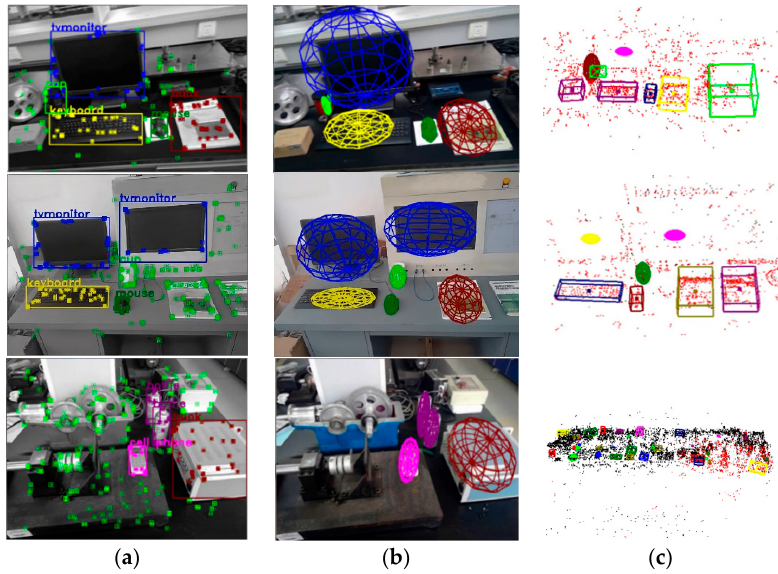
Figure 15. Running results of the object-oriented SLAM system in a real scene: ( a ) extraction of ORB feature points and YOLOv5 object detection; ( b ) ellipsoid representation of objects; ( c ) object-oriented level semantic maps.